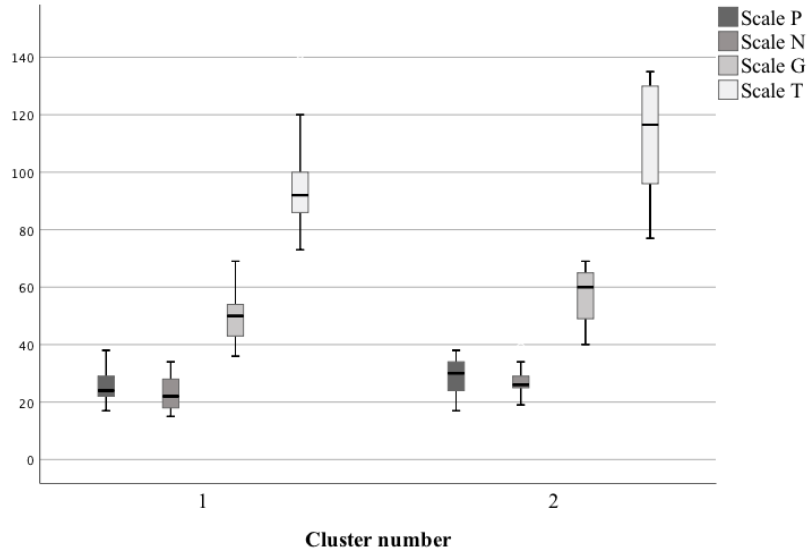
Figure 3. Scoring of the scales concerning the quality of life in selected clusters of patients. Additionally, a receiver operating characteristic (ROC) curve was prepared. The T scale allows us to significantly predict the belonging to the second group of people suffering from schizophrenia, i.e., with a reduced level of GLU 2.1 (ACC); AUC = 0.71 (Figure 4).